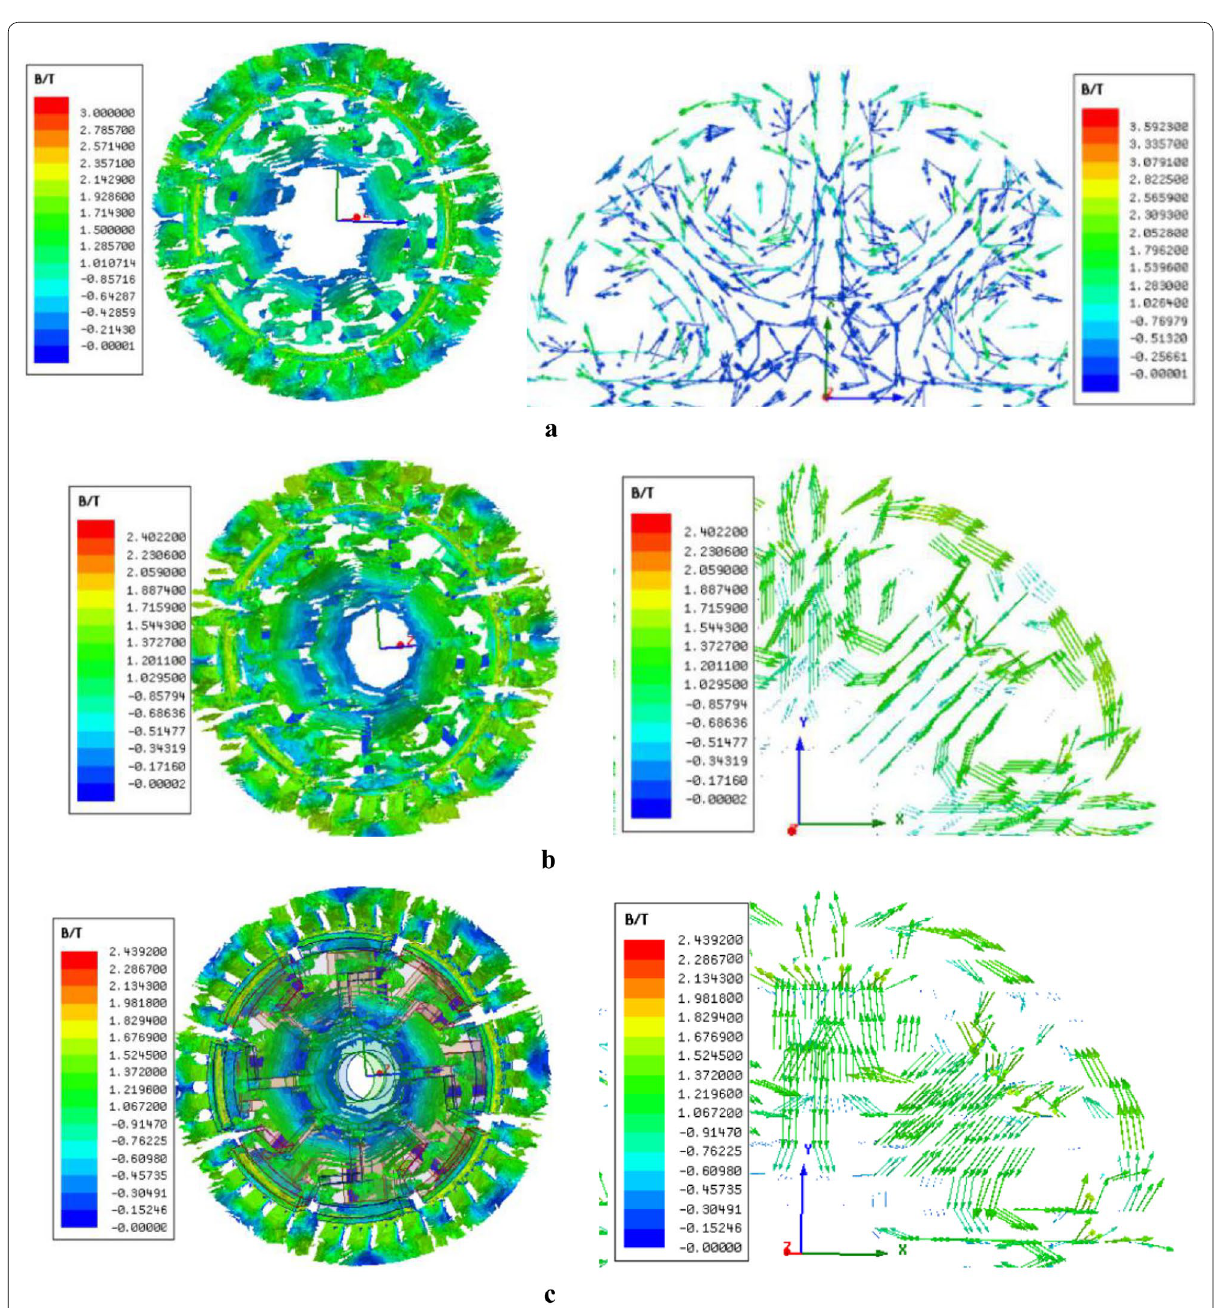
Figure 15 The magnetic flux density mold value diagram and vector diagram when electromagnetic rotor passed through with no current ( a ), forward current ( b ) and reverse current ( c